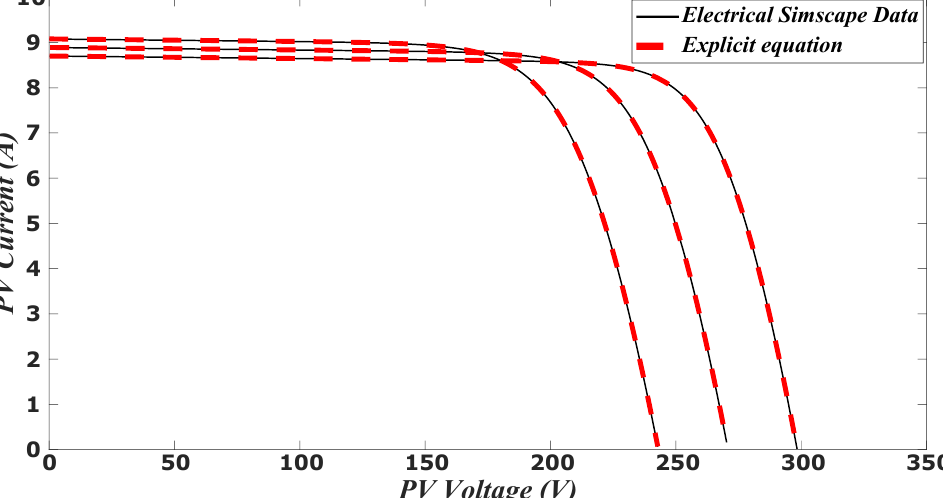
Figure 4. Comparison of the Simscape data and the explicit SDM with different temperature